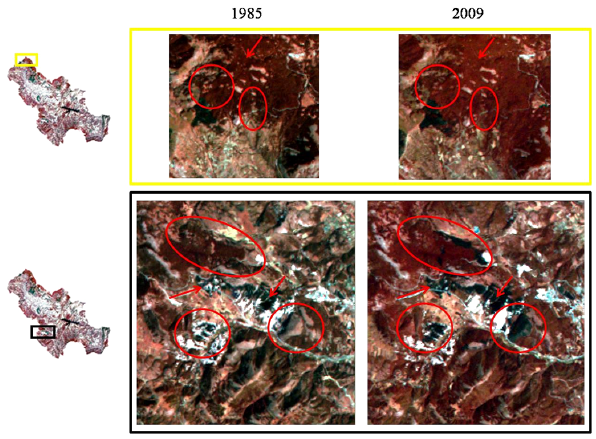
Figure 7. Examples of changes detected from 1985 and 2009 in the high Agri Valley: reduction of pastures and sparsely vegetated areas due to natural forest evolution of beeches (Be) on the top and coniferous (Co) afforestation on the bottom. The RGB composition (R – band 5; G – band 2; B – band 1) of Landsat 5-TM enhances broadleaved forests in dark red and coniferous forests in dark